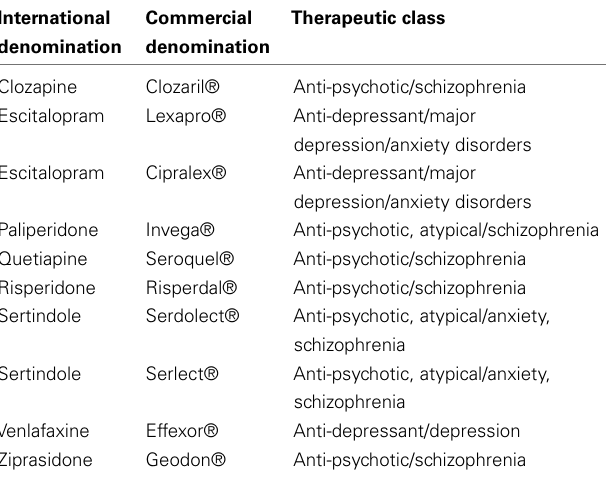
Table 3 | Psychotropic drugs implicated in the prolongation of the QT interval and in the genesis of torsades de pointes, but with a lack of sufficient evidence.